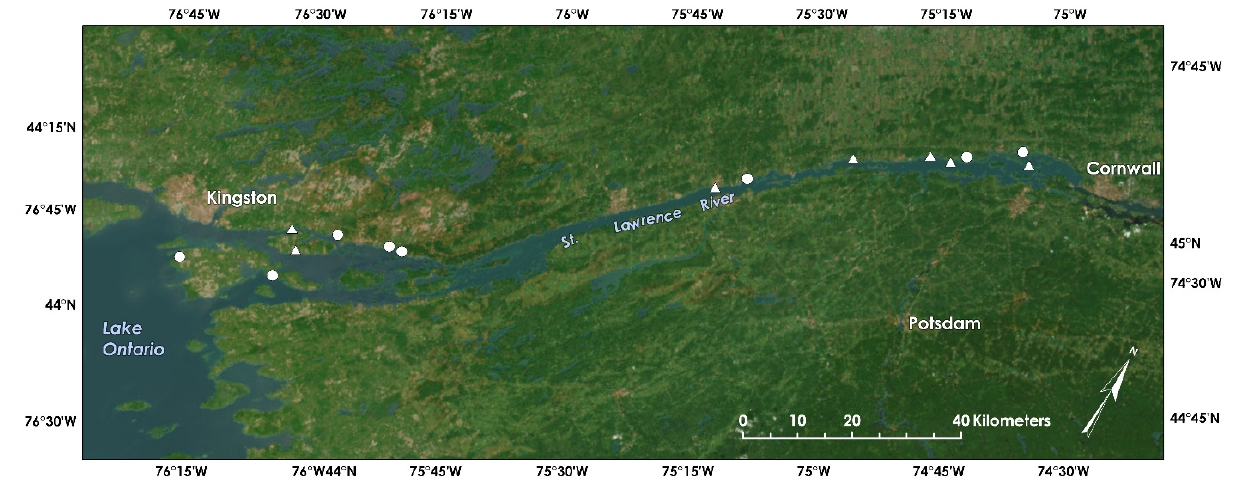
Figure 1. Riparian sampling sites along the International Section of the Upper St. Lawrence River. Wetland sites are circles; non-wetland sites are triangles. Map created in Esri’s ArcGIS Pro 2.8.2 (2021) [30]. Water flows from Lake Ontario north- east down the St. Lawrence